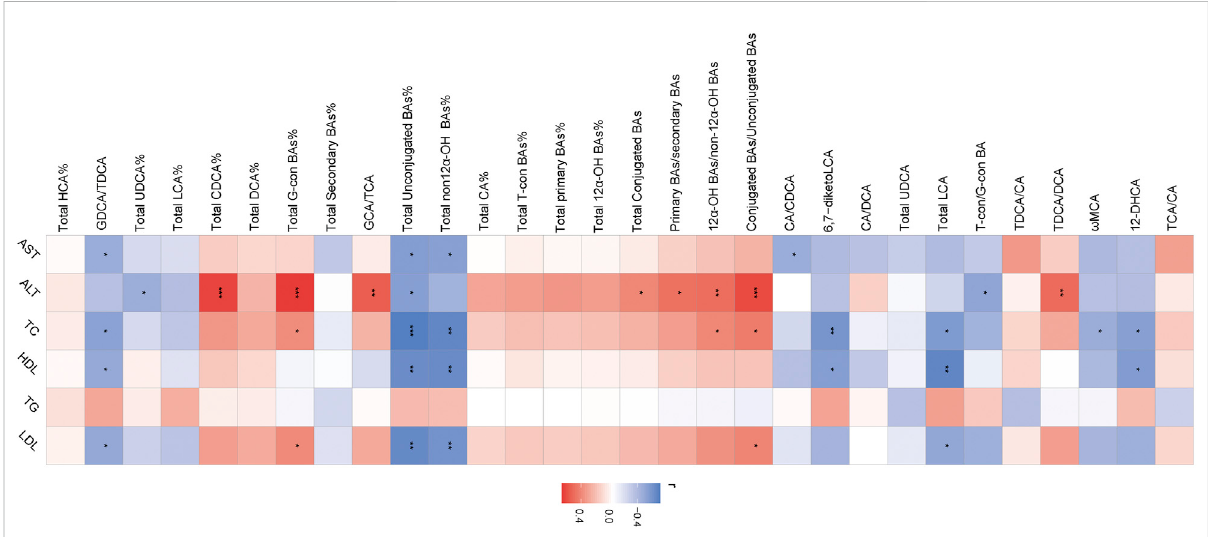
FIGURE 6 Heatmap ofSpearman correlation coef fi cients betweenliver BAsand serum bio-chemical parameters fromall samples inthethree groups. n= 22,sixsamplesforthecontrolgroup,andeightsamplesfortheothertwogroups.Thegradientcolorsrepresentthecorrelationcoef fi cients,withred color being more positive and blue color being more negative. * p < 0.05, ** p < 0.01, and *** p < 0.001 (Spearman ’ s correlation with the post hoc correction using the Holm